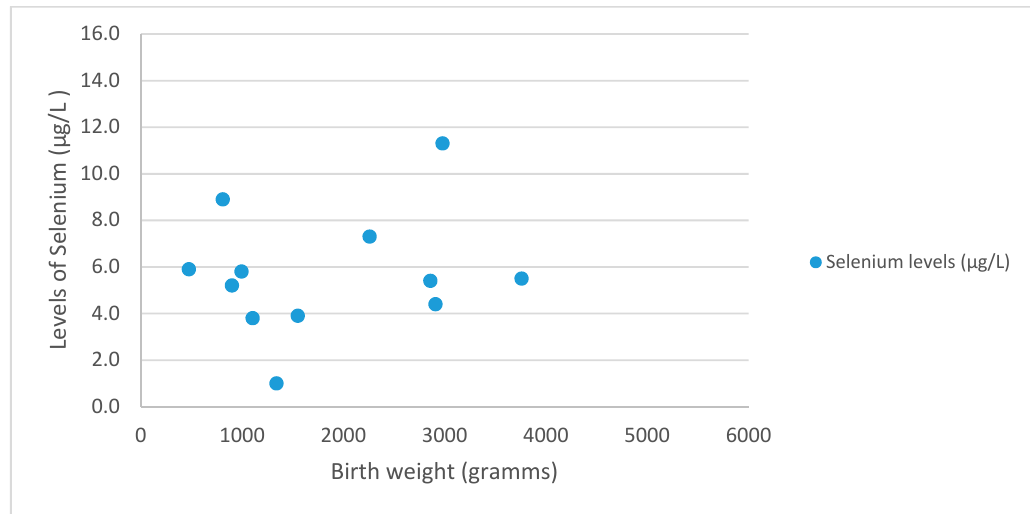
Figure 3. Distribution of birth weight in regard to Se levels in newborns with pre-eclampsia.